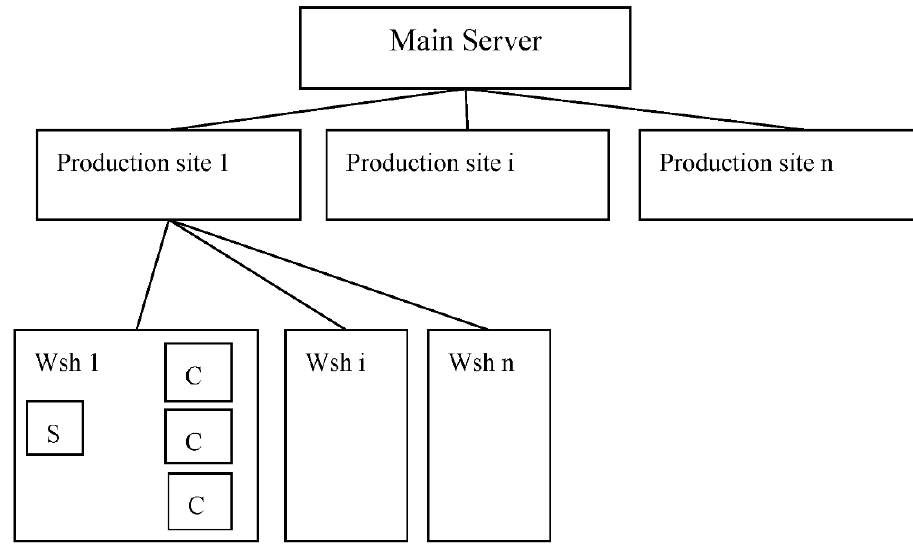
Figure 11. General production complex structure.